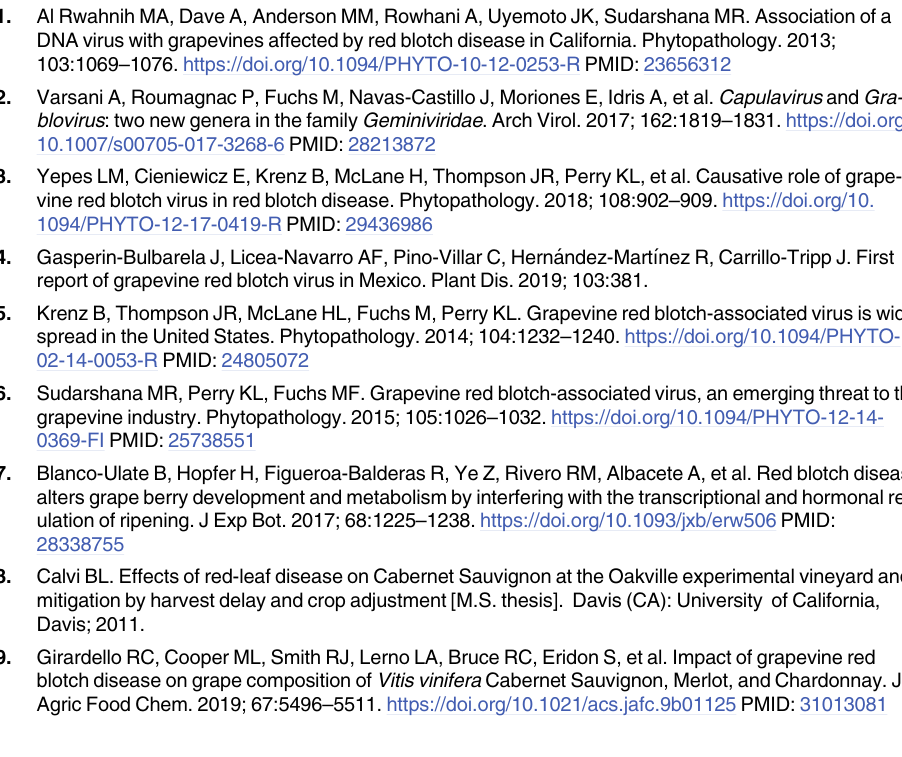
S1 Table. Raw data evaluating predation of the threecorned alfalfa hopper by six preda-